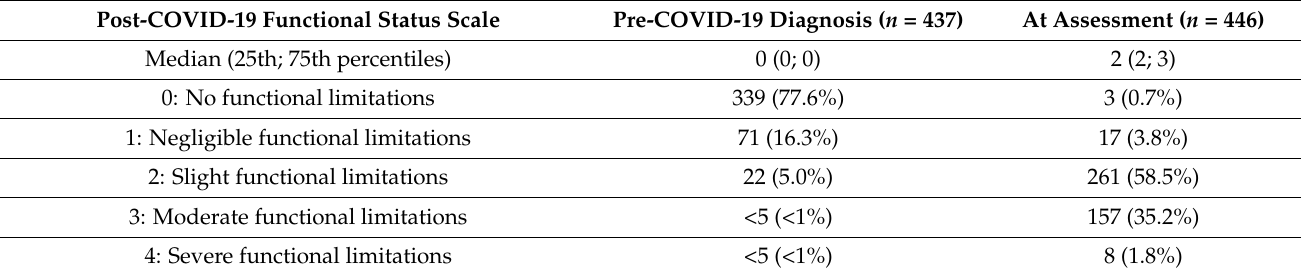
Table 3. The Post-COVID-19 Functional Status Scale. Evaluated in collaboration with the occupational therapist during assessment. Post-COVID-19 Functional Status scores at assessment are based on the current long COVID symptoms and general